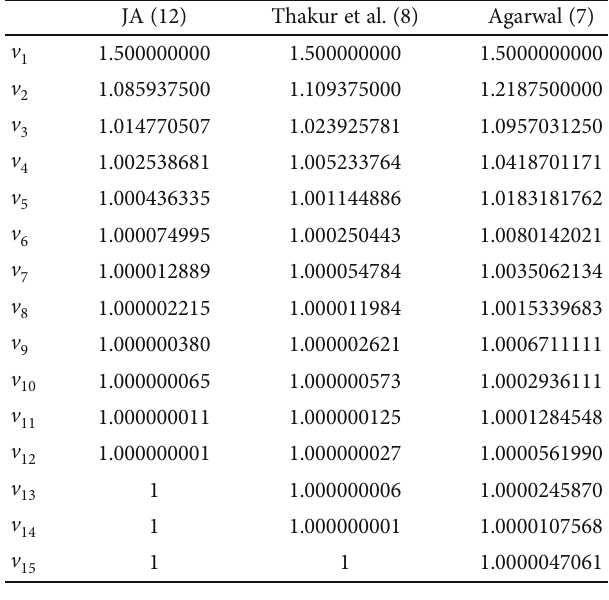
Table 1: Sequences generated by JA (12), Thakur et al. (8), and Agarwal (7) iterative